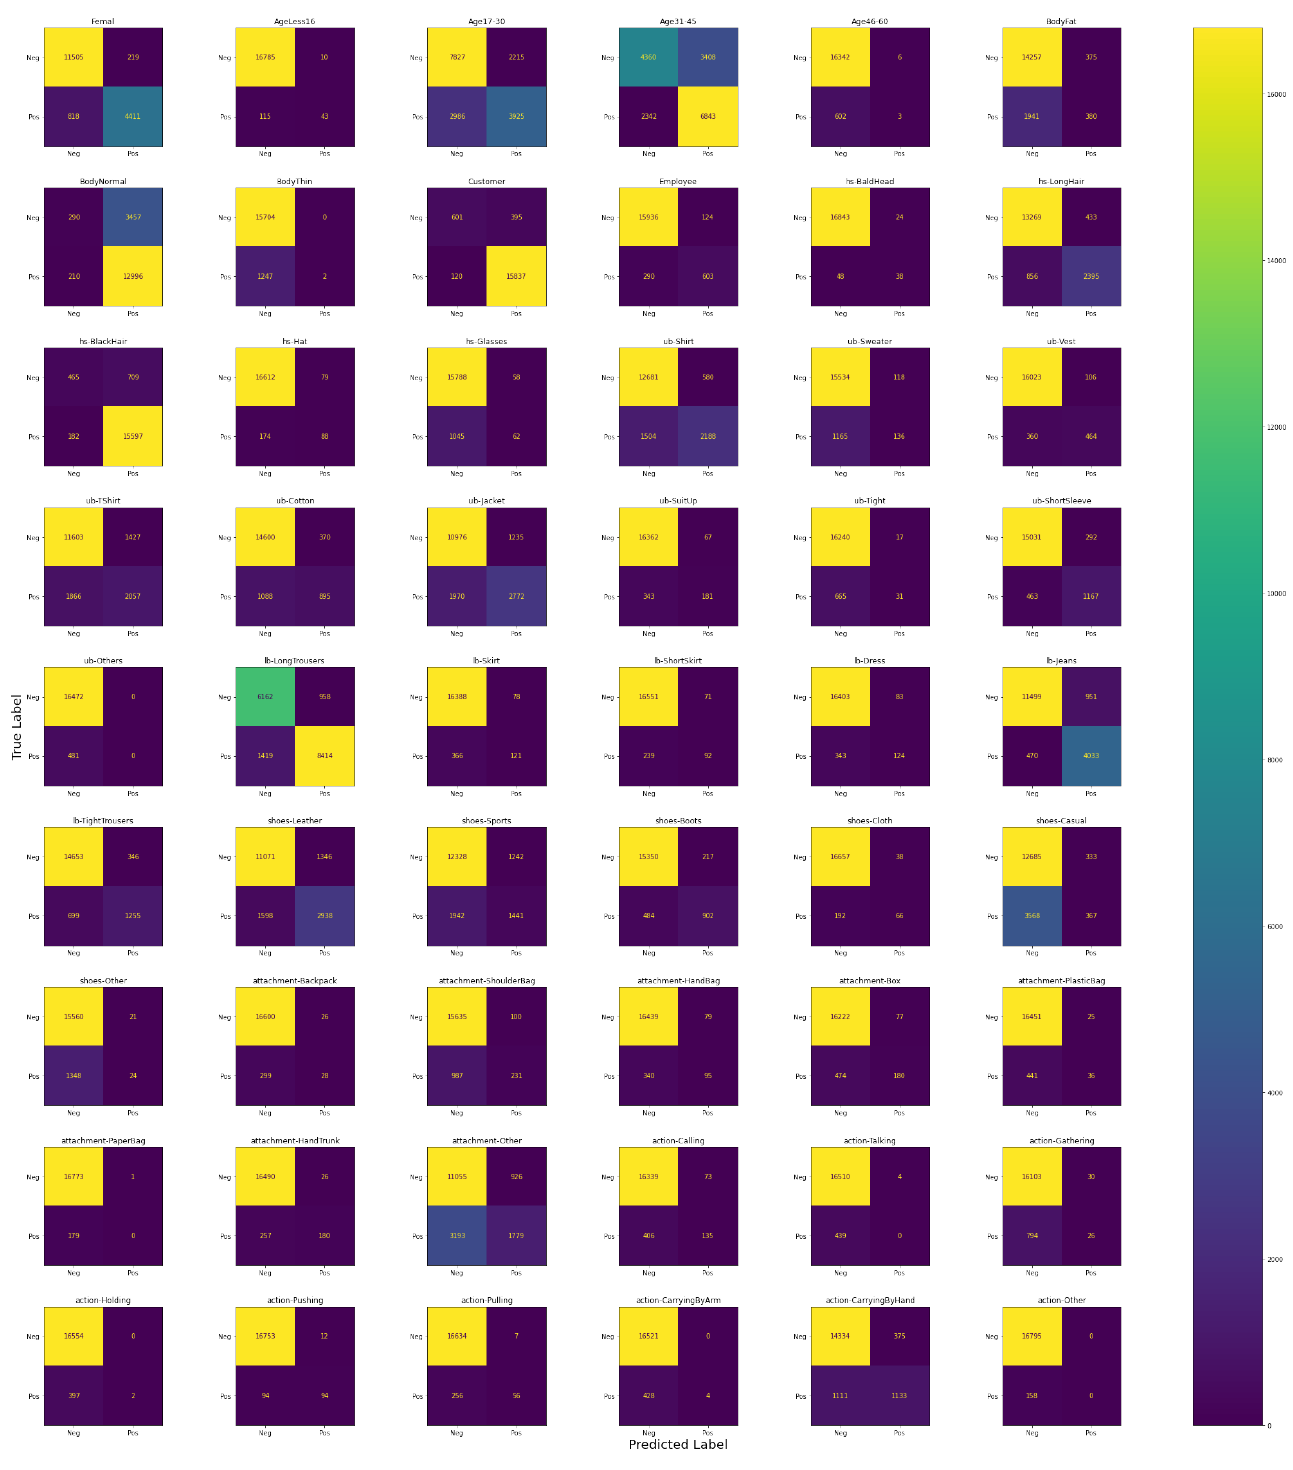
Figure 16. Confusion matrix of Model 5 on the RAP v2